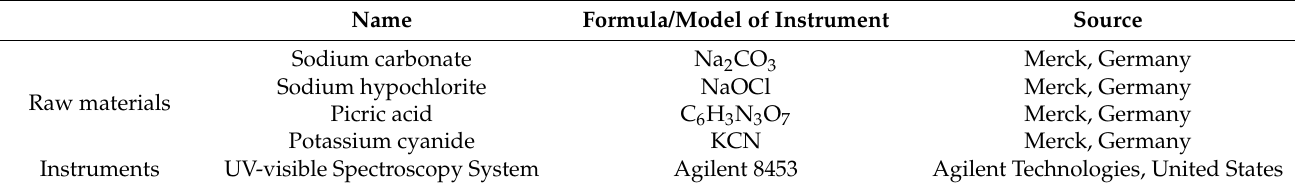
Table 2. Raw materials and instruments